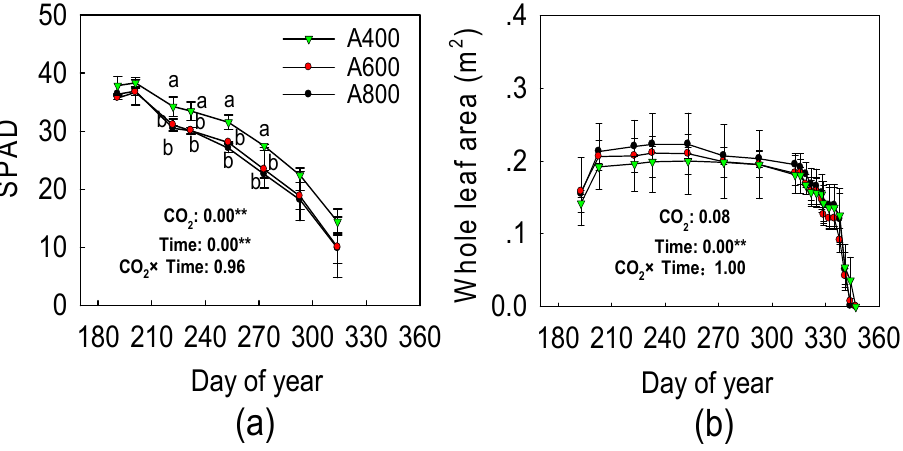
Figure 3. E ff ects of elevated CO 2 (A400—400, A600—600, and A800—800 µ L L − 1 ) on mean SPAD value ( a ) and whole plant leaf area ( b ) of red maple ( Acer rubrum L.). The values shown are mean ± SD. Di ff erent lowercase letters above bars mean significant multiple comparison results among [CO 2 ] treatments when p < 0.05, n = 3. The ANOVA results of (CO 2 ) treatments (CO 2 ), time, and the interaction (CO 2 × time) are shown in the figure, ** means p < 0.01.